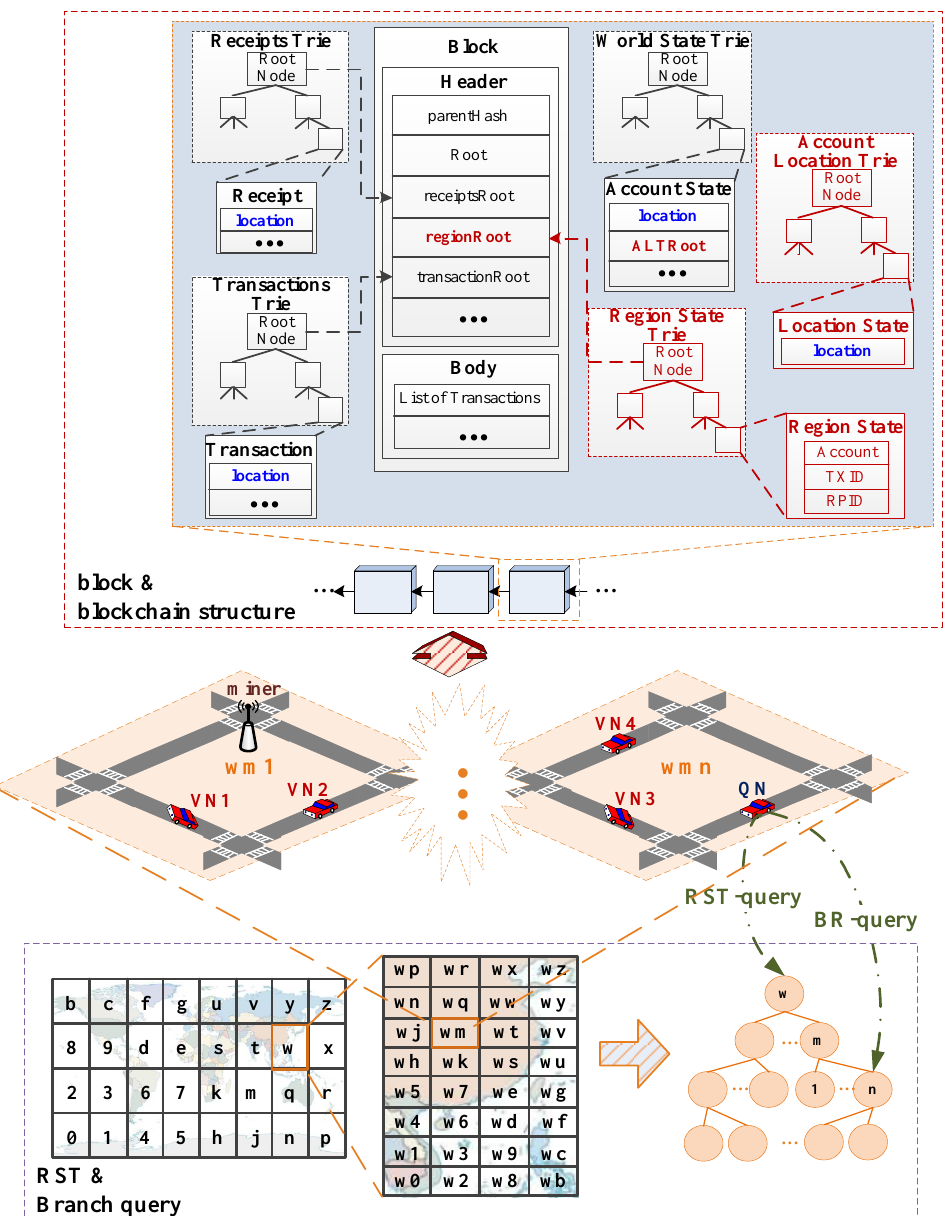
Figure 1. The proposed structural model. Where miner is used to packing the block, VN is a vehicle node, QN is a query node, RST-query means that the query node queries the regional information according to the RST method, BR-query means that the query node queries the regional information according to the branch query